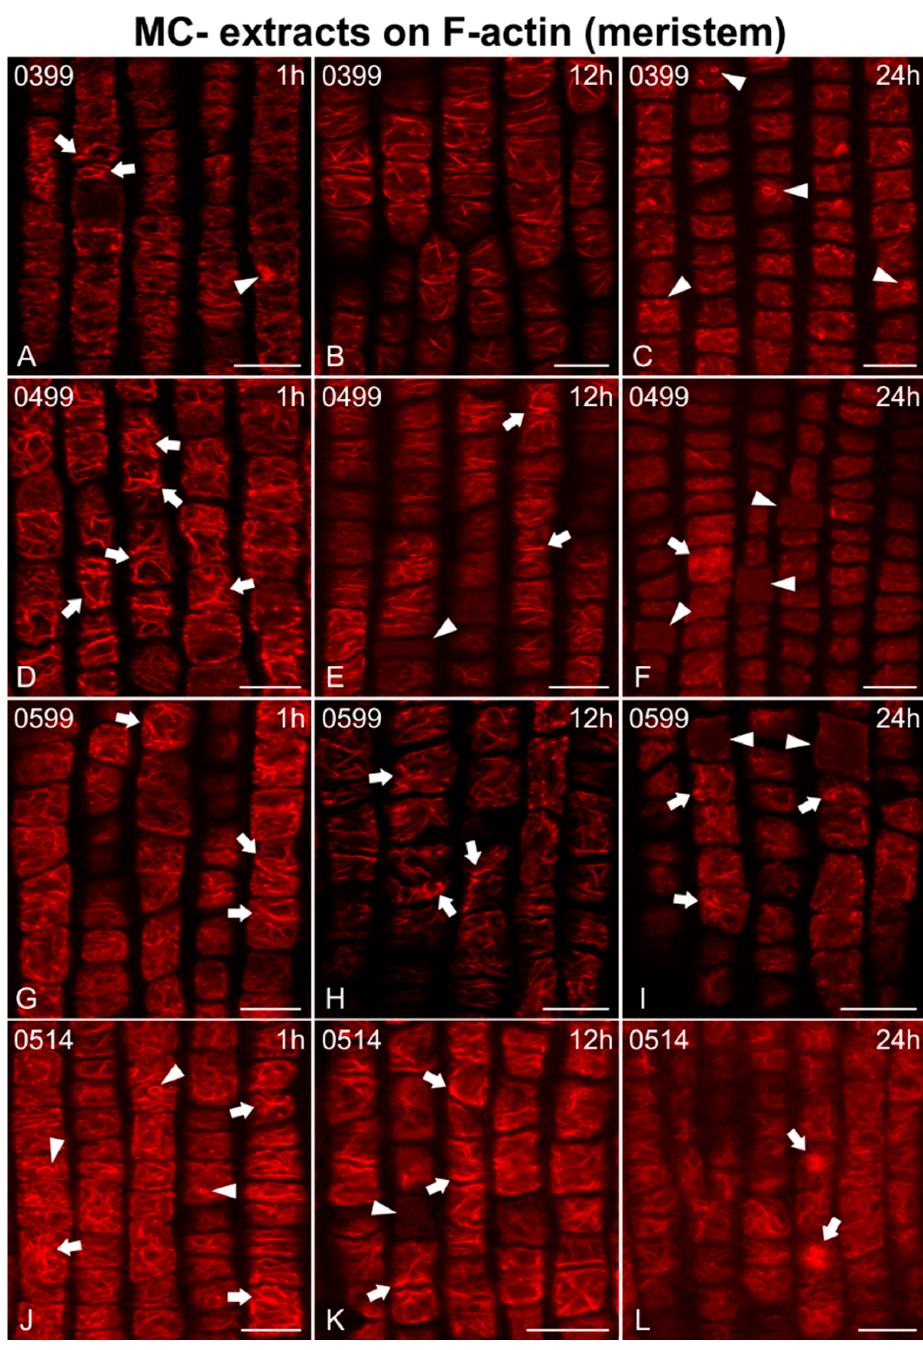
Figure 5. Single cortical CLSM sections of Oryza sativa root protodermal cells stained for F-actin, after treatment with MC − extracts from various non-MC-producing strains: Calothrix epiphytica TAU-MAC 0399 ( A – C ), Synechococcus sp. TAU-MAC 0499 ( D – F ), Chlorogloeopsis fritschii TAU-MAC 0599 ( G – I ), and Planktothrix agardhii TAU-MAC 1614 ( J – L ). Root tips in all images point towards the bottom of the page. Cells treated for 1 h exhibited disoriented/branched and bundled (arrows in A , D , G , J ) cortical actin filaments, along with actin aggregates (arrowhead in A ) and actin rings (arrowheads in J ) in some cases. Scarce disoriented ( B , H ) and bundled (arrows in E , H , K ) were also reported after 12 h, while, occasionally, cells devoid of F-actin (arrowheads in E , K ) could be observed. After 24 h, actin filaments were weak and scarce ( C , F , I ) or heavily disoriented ( L ) with actin aggregates (arrows in F , L ) and bundles (arrows in I ), while actin rings (arrowheads in C ) or cells almost without detectable F-actin (arrowheads in F , I ) could be noticed. Scale bars: 10 µ